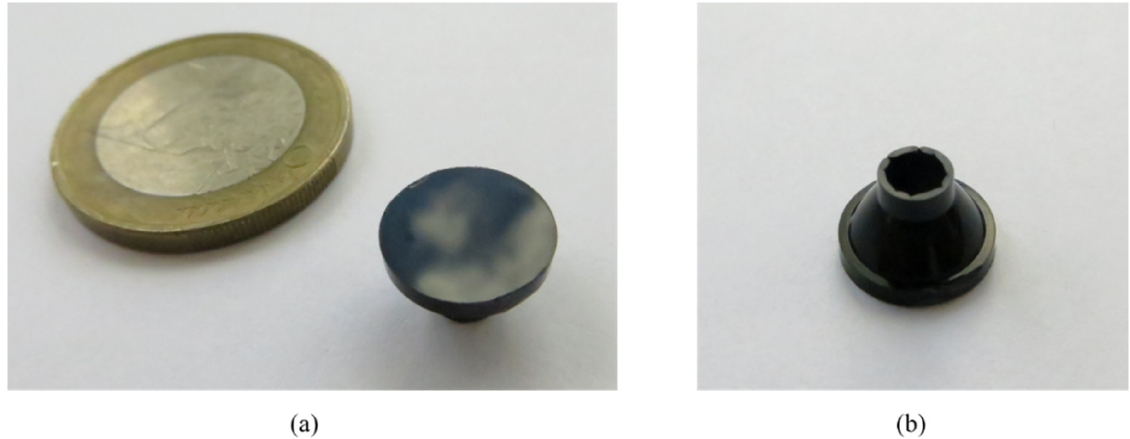
Figure 3. TIR lens prototype. ( a ) Perspective top view. ( b ) Perspective bottom view.